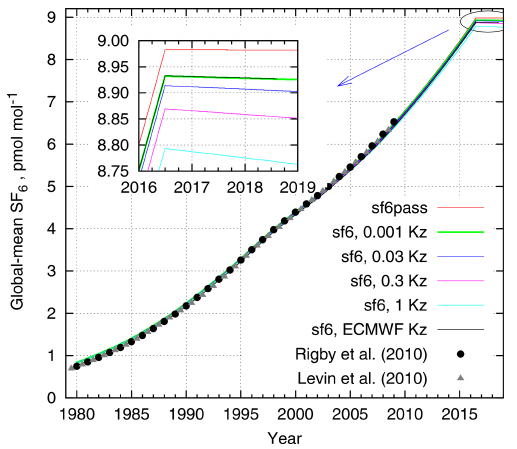
Figure 9. The time series of mean mixing ratio of SF 6 in the at- mosphere simulated with emissions stopped in July 2016. The total burdens by Levin et al. (2010) and by Rigby et al. (2010) are shown for comparison.